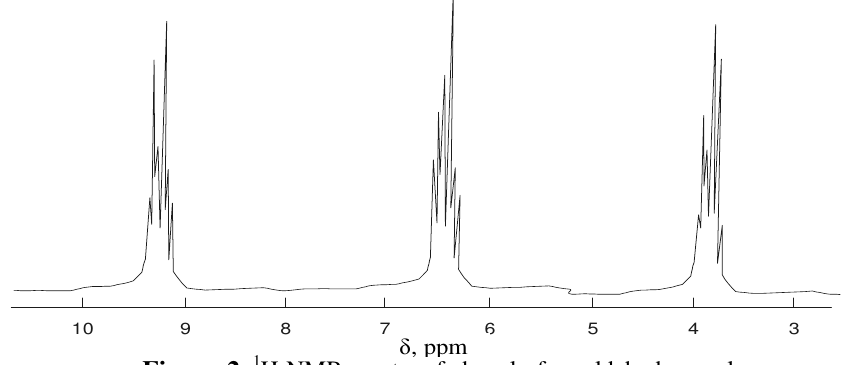
Figure 2 . 1 H-NMR spectra of phenol - formaldehyde